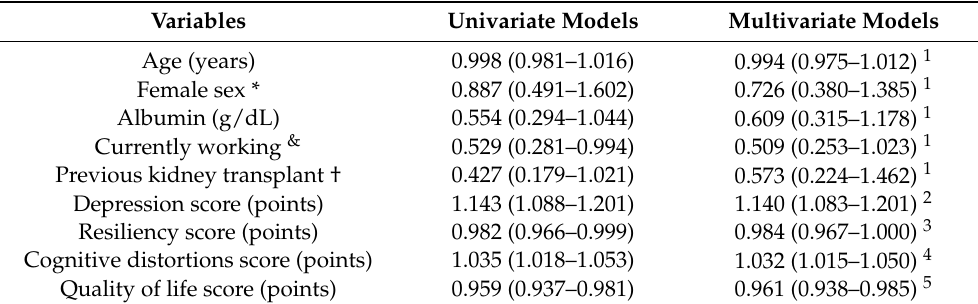
Table 5. Binary logistic regression analysis to assess the variables associated with the presence of anxiety (dependent variable). Results are shown as odds ratio